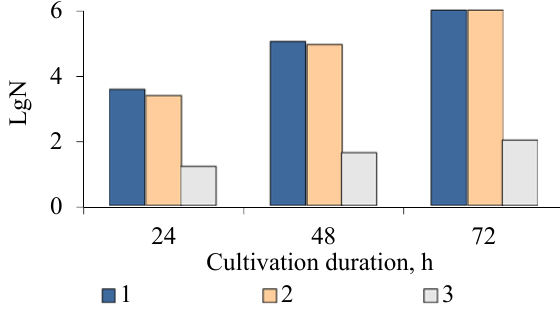
Fig. 3. Dynamics of the number of Bifidobacterium adolescentis MC 42 (lgN) cells in the nutrient medium that contains cedar oil (5.0% emulsion in water) after 24 h, 48 h and 72 h of fermentation: (1) oil (cold pressing); (2) oil (heat pressing); (3) control (a culture medium that does not contain any potential antioxidant agents). The data are expressed as a mean ± standard deviation ( n = 5).